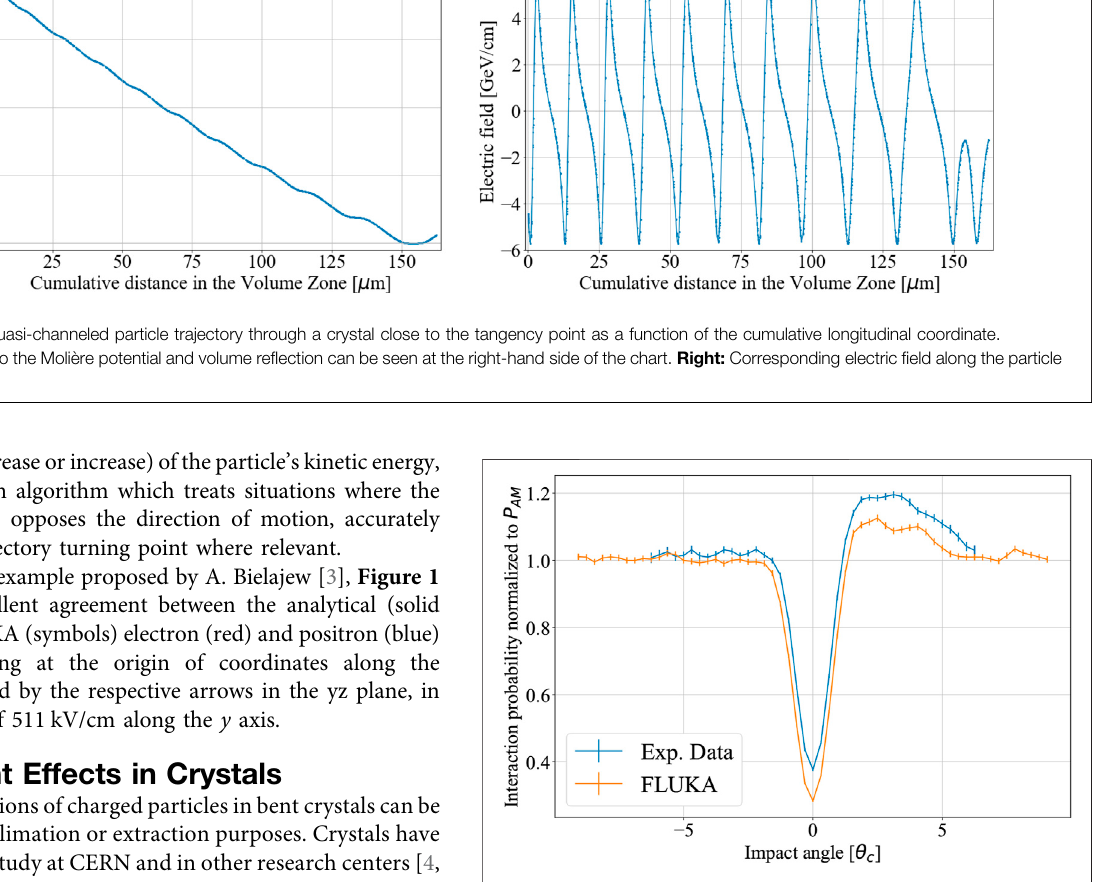
FIGURE4| Nuclearinteractionrateasafunctionoftheparticleincoming angle, normalized to the interaction rate in amorphous mode. The dip corresponds to channeled particles, experiencing low interaction rate in the channel. The excess observed for small positive angles corresponds to the increased rate experienced by quasi-channeled particles when crossing multiple channels. Experimental data from